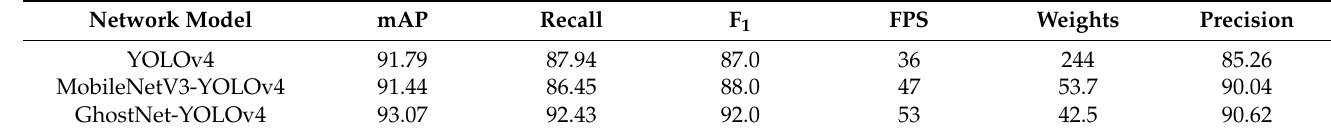
Table 3. The performances of the models using different backbone